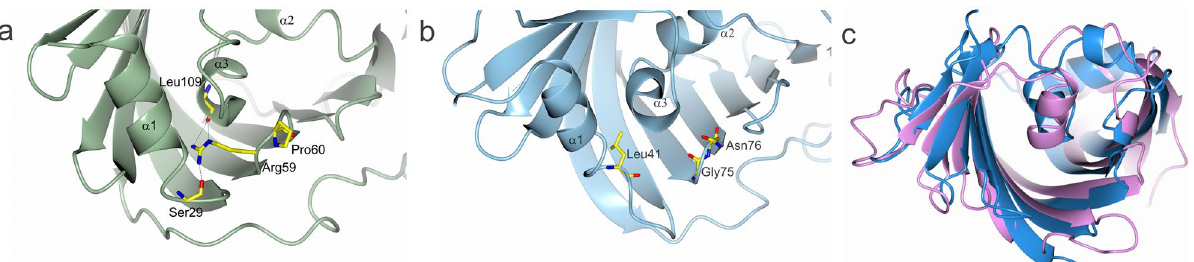
Figure 3. A comparison of the binding clefts in LolA. ( a ) In γ-proteobacteria, such as V. cholerae , an Arg-Pro motif (Arg59 and Pro60 in LolA-VC) is conserved. In E. coli the motif has been shown to be important for the interaction with LolB and the transfer of lipoproteins. With no binding partner bound in the cleft of LolA-VC Arg59 hydrogen bonds to main chain atoms at the end of α1 and of α3. ( b ) In LolA-PG the position equivalent to Arg59 is occupied by Gly75. The space that is filled by the Arg59 side chain in LolA-VC is filled with Leu41 in LolA-PG. ( c ) Overlay of LolA-EC in blue and LolA-PG in pink showing the similar size and shape of their